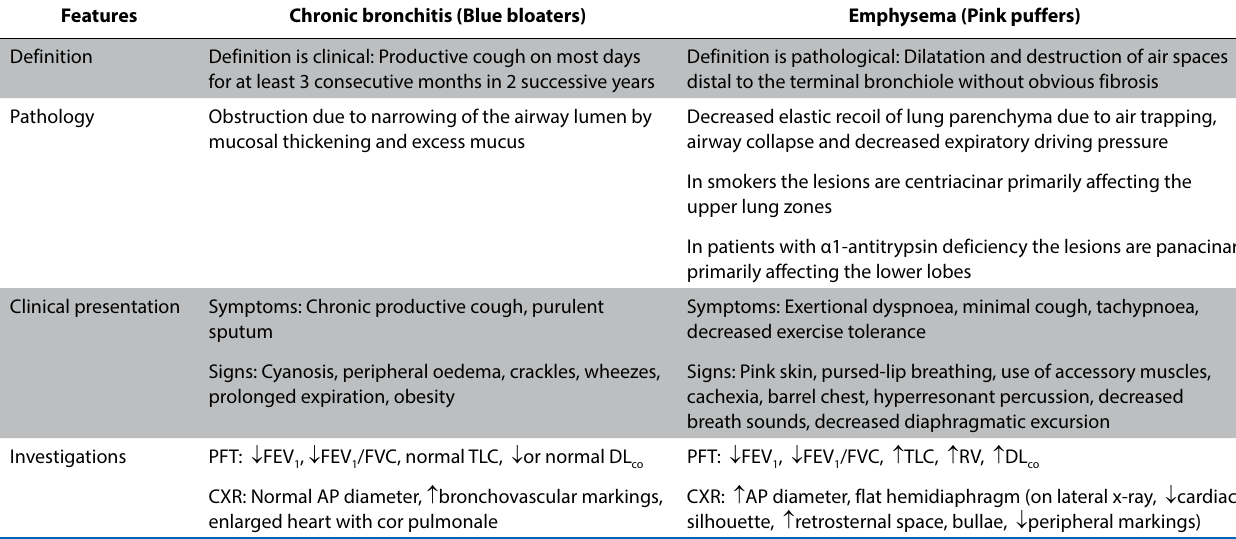
Table 1. Features distinguishing chronic bronchitis from emphysema